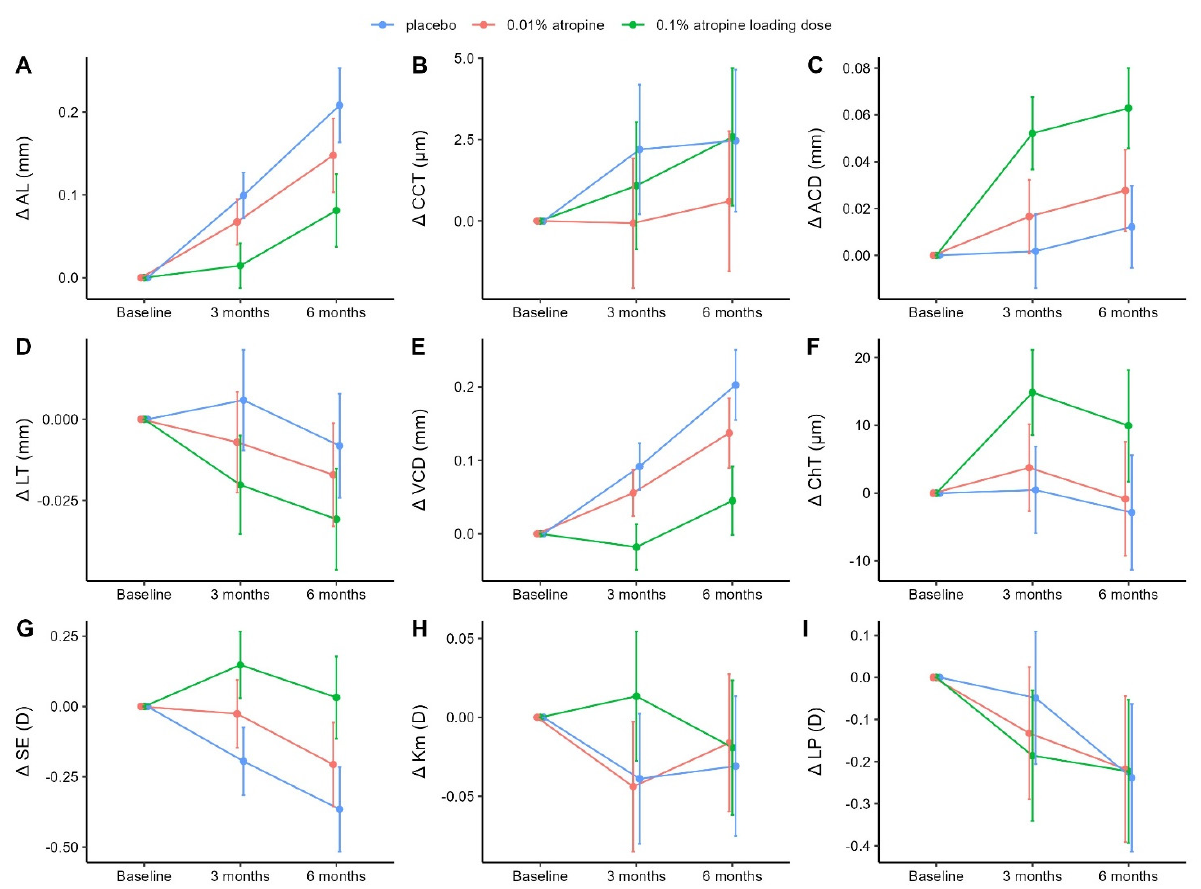
Figure 1. Diagrams showing changes in ocular biometrics and refractive parameters from baseline to six-month visit with placebo (blue), 0.01% atropine (red), and 0.1% atropine loading dose (green). Mean values are indicated by dots, whereas vertical error bars indicate the 95% CIs of the mean changes. Means and CIs were derived from the constrained linear mixed model with inherent baseline adjustment. ( A ), Change in AL in treatment groups over six months. ( B ), Change in CCT in treatment groups over six months. ( C ), Change in ACD in treatment groups over six months. ( D ), Change in LT in treatment groups over six months. ( E ), Change in VCD in treatment groups over six months. ( F ), Change in ChT in treatment groups over six months. ( G ), Change in SE in treatment groups over six months. ( H ), Change in Km in treatment groups over six months. ( I ), Change in LP in treatment groups over six months. Abbreviations: Δ = change in; ACD = anterior chamber depth; AL = axial length; CCT = central corneal thickness; ChT = choroidal thickness; CI = confidence interval; D = diopters; Km = mean anterior corneal curvature; LT = lens thickness; LP = lens power; SE = spherical equivalent; VCD = vitreous chamber depth.